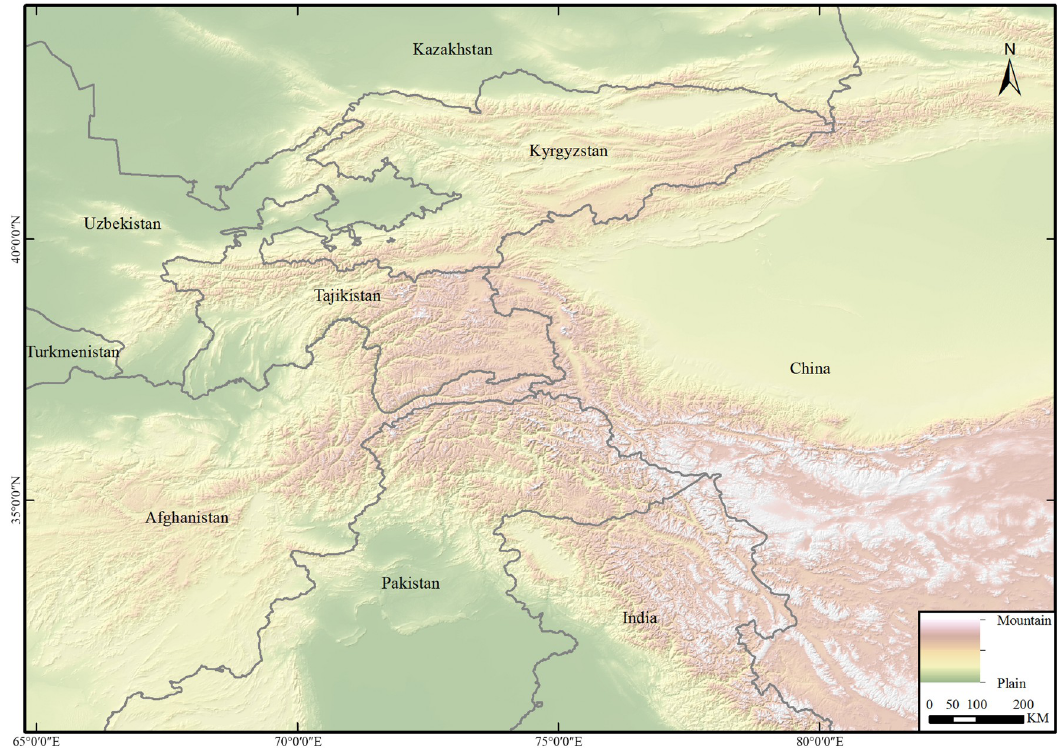
Fig 1. The research area. The elevation depicted by the digital elevation model (DEM). DEM was obtained from USGS Earth Explorer (https://earthexplorer.usgs.gov); the boundary was obtained from Natural Earth (http://www.naturalearthdata.com/), which is a schematic line illustrating the relative position of each country and should not be re-used or misinterpreted for any political reason.